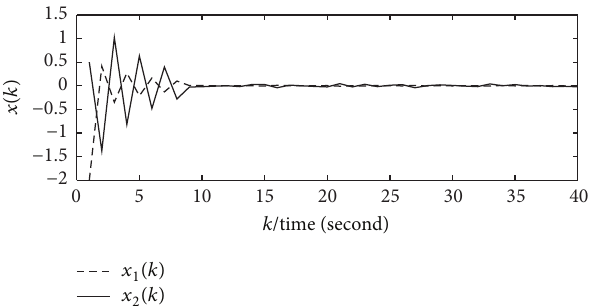
Figure 5: Response curves of system states 𝑥(𝑘) with stochastic switching signal.